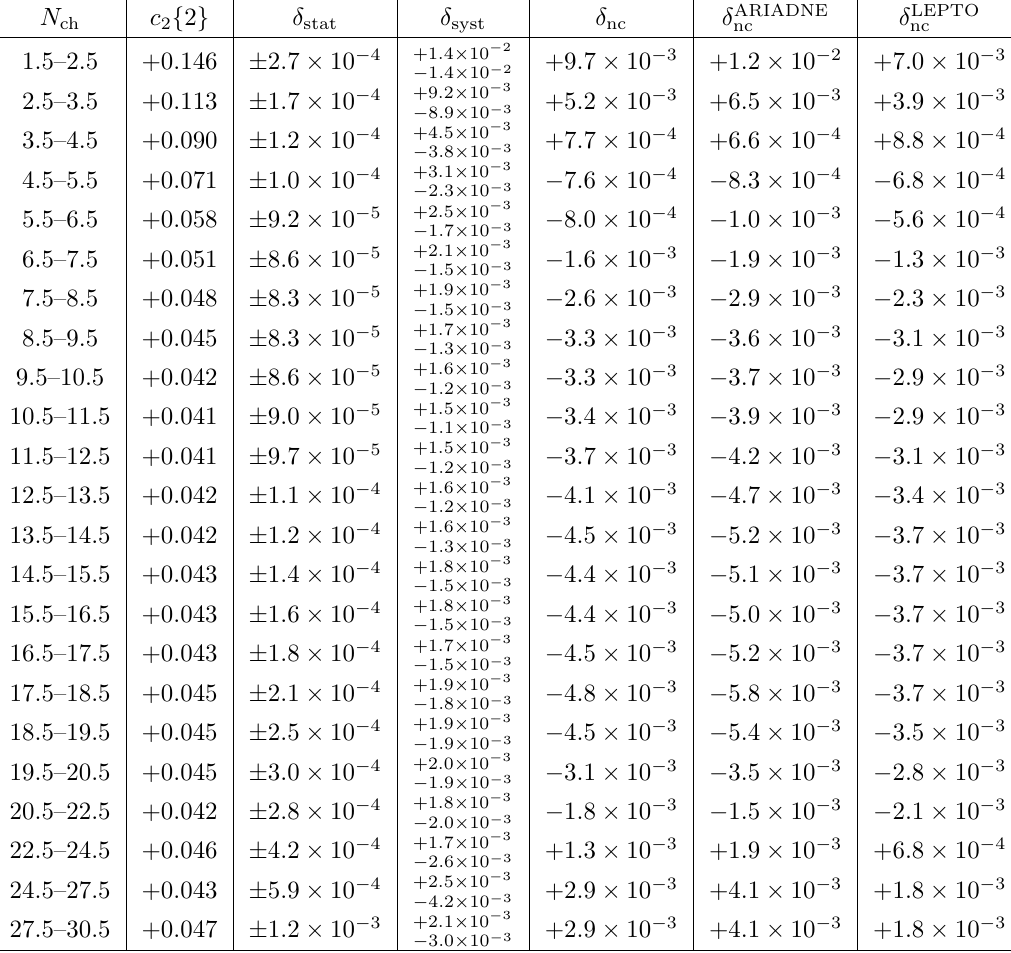
Table 4 . c 2 f 2 g versus N ch from (cid:12)gure 7 (b) and (cid:12)gure 10 (b), p T > 0 : 1 GeV, no j (cid:1) (cid:17) j cut; (cid:14) stat , (cid:14) syst and (cid:14) nc denote the statistical, systematic and Monte Carlo non-closure uncertainties,